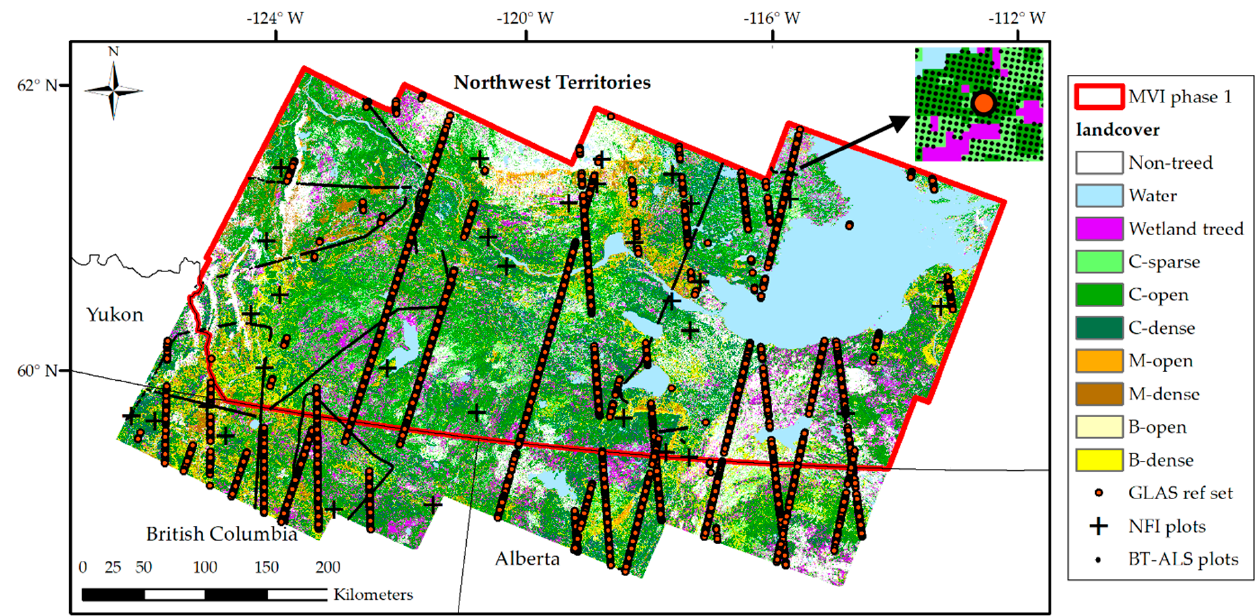
Figure 1. MVI phase 1 study area (red outline) within a broader area across 2 provinces and 2 territories (separated by thin black outline) that has as a backdrop a ca. 2007 landcover map that includes forest cover types (C: conifer; M: mixedwood; B: broadleaf) with 3 density classes (sparse, open, dense) along with the Geoscience Laser Altimeter System (GLAS) reference dataset of surrogate forest inventory (FI) plots and 2 validation sample sets. The top right zoomed-in inset shows a single GLAS FI plot surrounded by BT − ALS plots in a 500 m by 500 m area corresponding to an intersection between the BT − ALS transect and an ICESat track. Map is in Albers equal area conic projection.